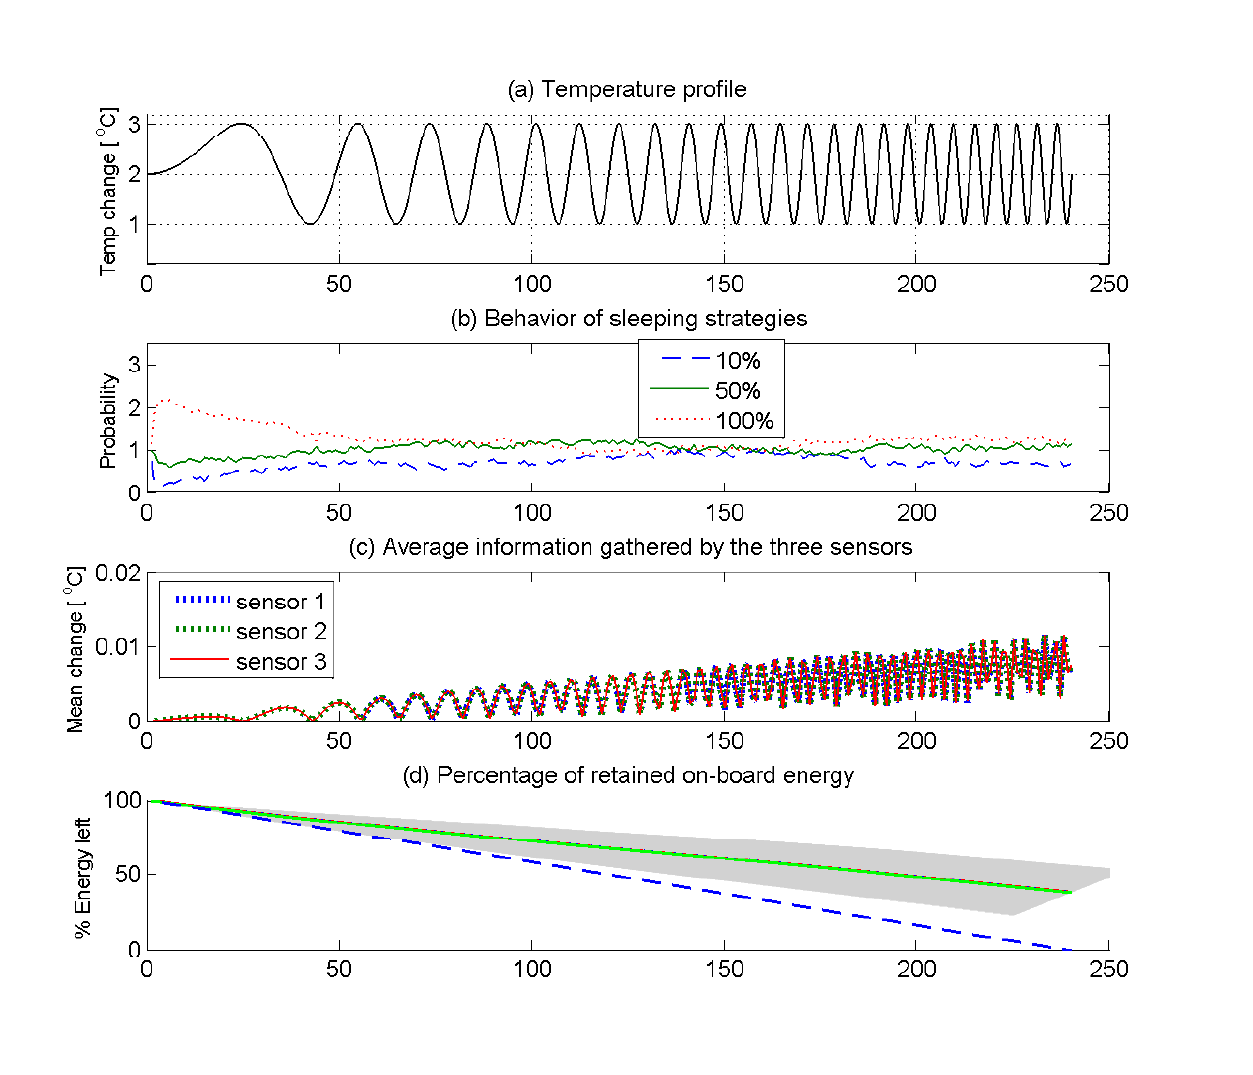
Figure 7. Adaptive behavior of a cluster of sensor nodes following a Markov decision process in a stochastic